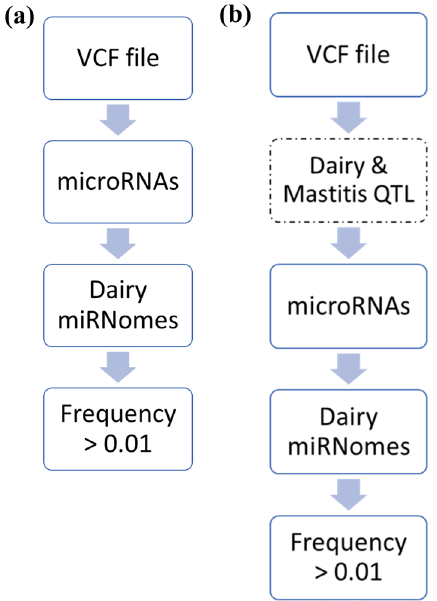
Figure 5. Data filtering process without ( a ) and with ( b ) the dairy and mastitis QTL filter. From the genetic variants in the VCF file, different filters were added to kept the variants of interest. The main steps of the pipeline are as follows and step 2 was present only in ( b ). (1) vcf files annotated with either VEP or SnpEff were used to filter only variants that are located in microRNA regions. (2) Positions of the previously filtered variants